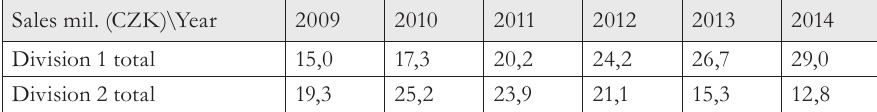
Tab. 3. – Comparison between Division 1 and Division 2. Source: